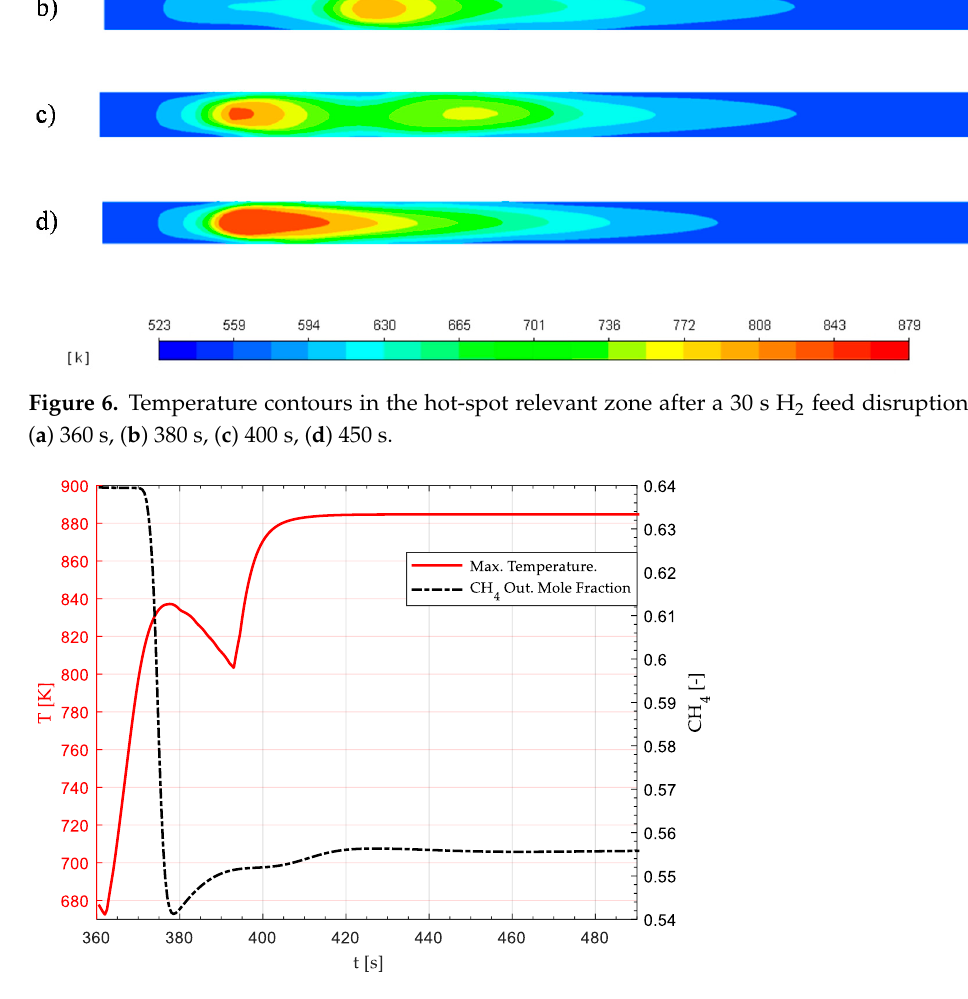
Figure 7. Effect of a 30 s H 2 feed disruption on the methane mole fraction at reactor outlet and the maximum reactor temperature. H 2 feed disruption occurs from 330 s to 360 s (from reactor standby). At 360 s, H 2 feed is resumed. The original steady state is completely recovered at t = 450 s.